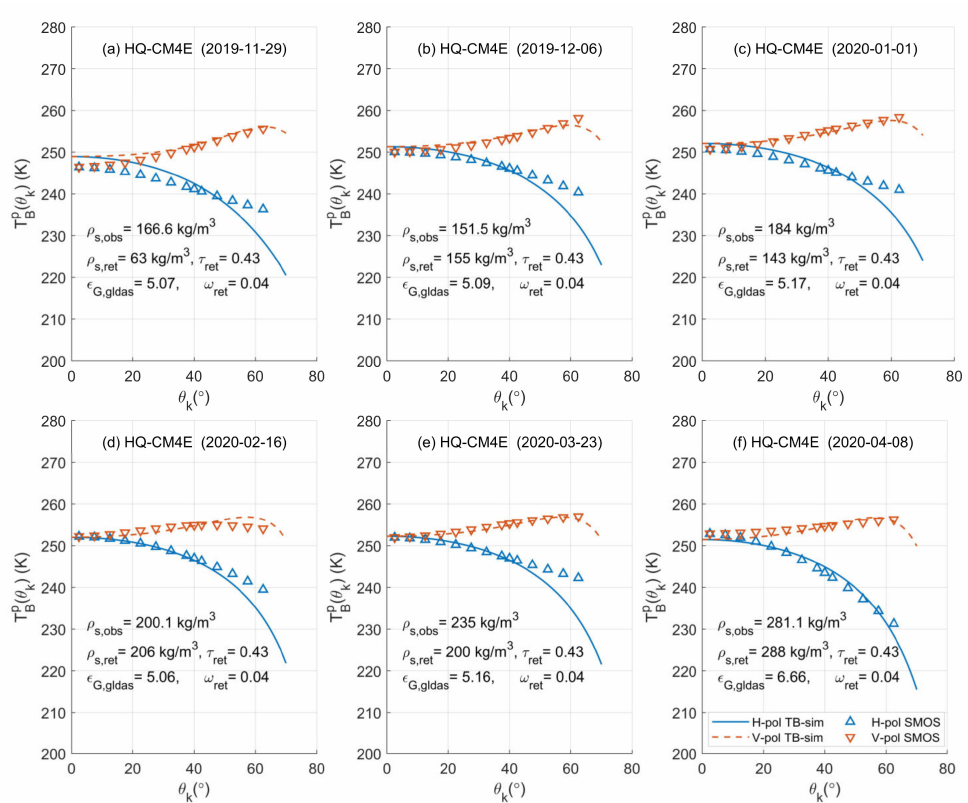
Figure 4. Examples of SMOS-observed T B (triangles) versus the forward-model-simulated T B (lines) to fit the observations. τ ret and ω ret are the retrieved snow density, τ , and ω , respectively. ε G , gldas is the soil permittivity calculated from the GLDAS soil